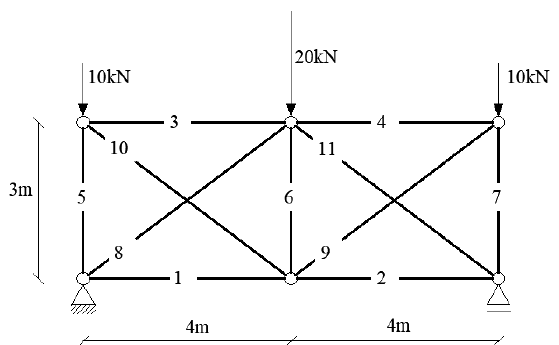
Figure 2. Statically indeterminate truss with two degrees of freedom.